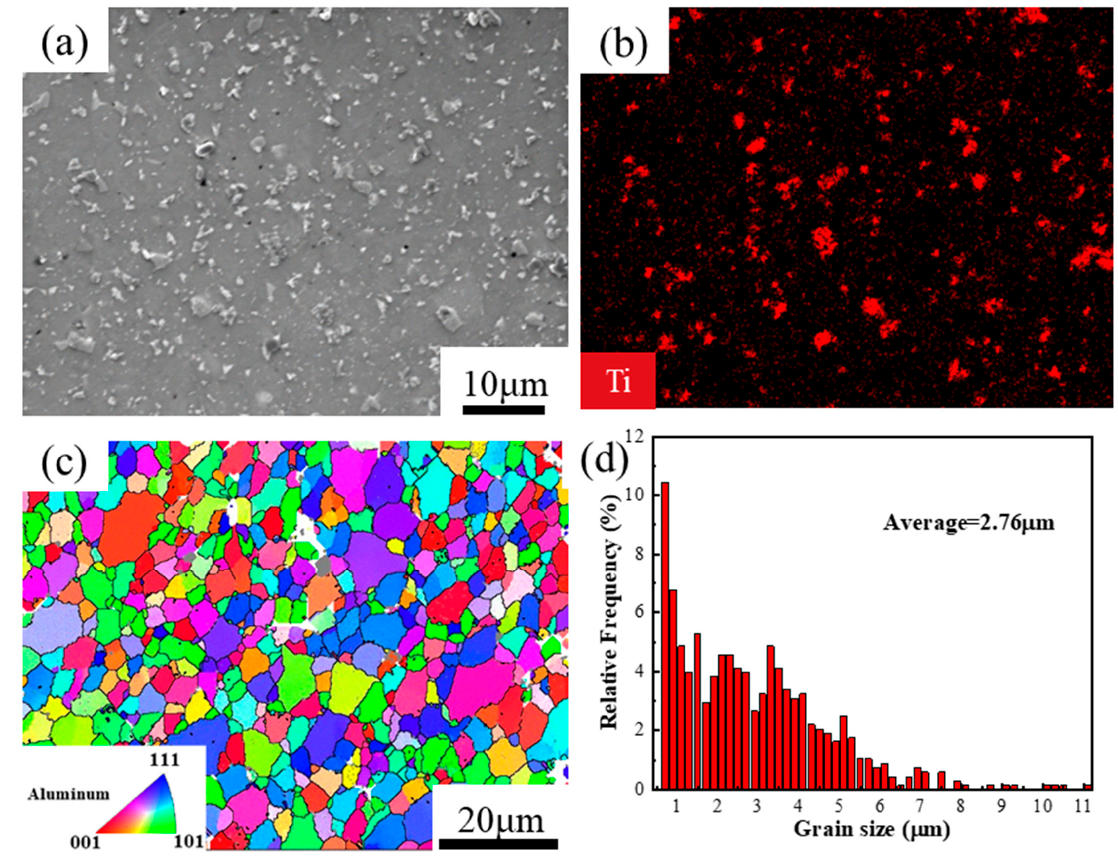
Figure 1. The initial microstructures of the powder metallurgy (PM) composites by scanning electron microscopy (SEM) and electron back-scattered diffraction (EBSD): ( a ) SEM morphology map, ( b ) Ti element distribution of ( a ), ( c ) EBSD map (high-angle grain boundaries (HAGBs) are in black lines, the gray phases are TiB 2 particles, the white color regions are zero-solutions regions), ( d ) the grain size distribution of ( c ).